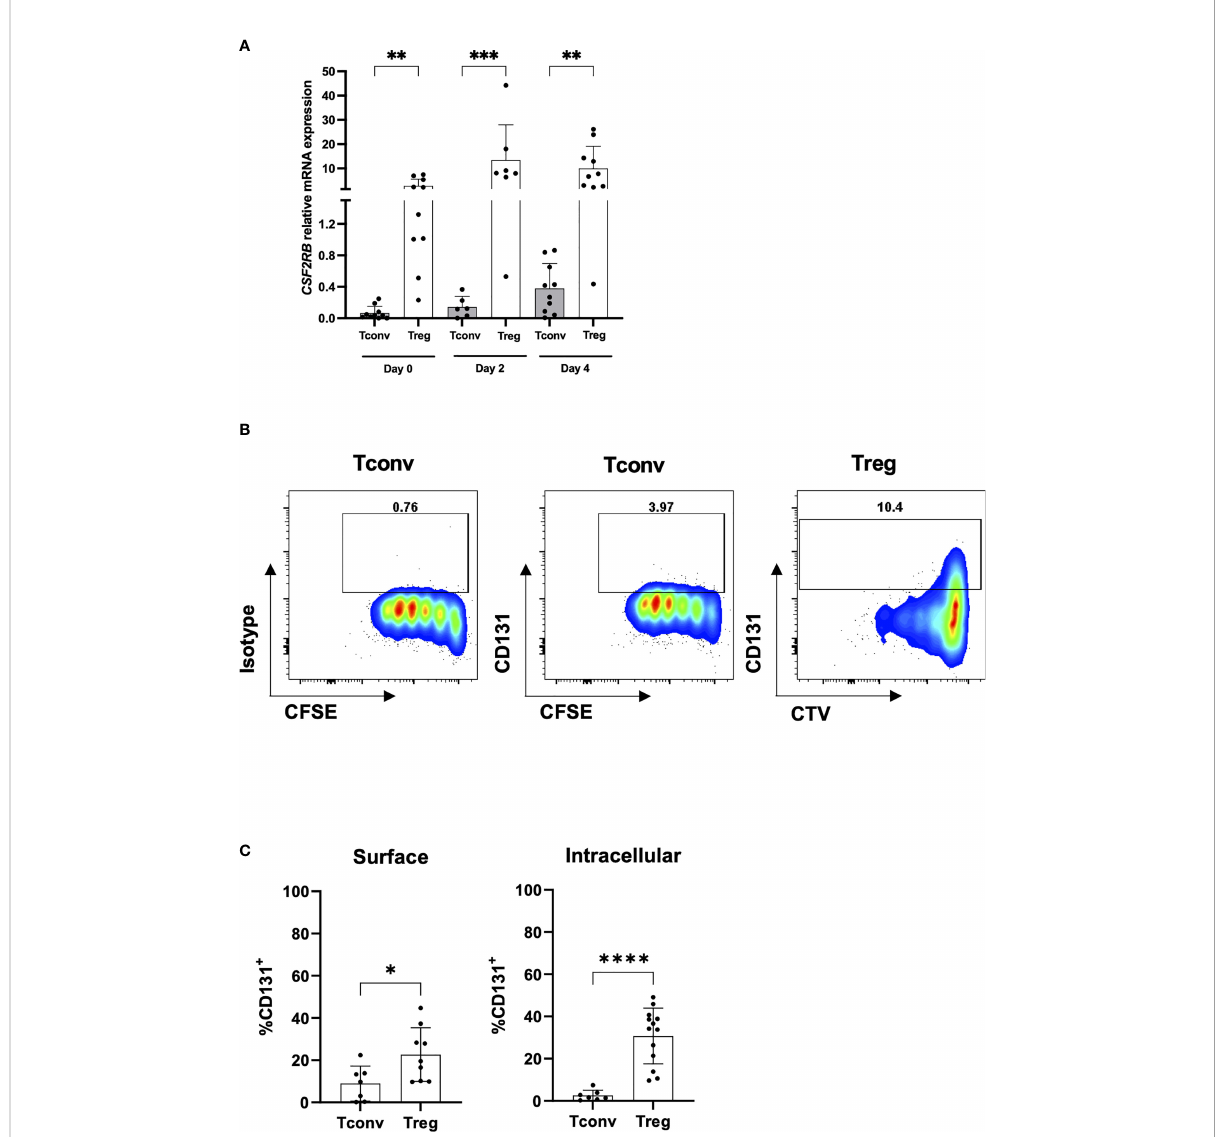
FIGURE 2 CD131 expression on TCR-stimulated CD4 + CD25 - Tconvs and Tregs. (A) Relative CSF2RB mRNA levels in fl ow-sorted CD4 + CD25 - CD127 + Tconv and CD4 + CD25 + CD127 - Treg cells from human PBMCs upon in vitro stimulation with anti-CD3/CD28 mAbs and IL-2. Cells were stimulated with 1 or 10µg/ml anti-CD3 mAb, 1µg/ml anti-CD28 mAb and 25 or 300U/ml IL-2 (n= 6-10). The relative quantities of CSF2RB mRNA were normalized to the expression of B2M mRNA. Graph includes data from Figure 1A at day 0 for comparison (B) CD131 intracellular protein expression was studied in CD4 + CD25 - CD127 + Tconvs and CD4 + CD25 + CD127 - Tregs fl ow-sorted from human PBMCs, labelled with cell proliferation trackers CFSE or CTV and in vitro -stimulated with anti-CD3/CD28/CD2 coated beads for 4 days in the presence of 25U/ml IL-2. One representative donor out of two is shown. (C) CD131 surface and intracellular protein expression was studied in CD4 + CD25 - CD127 + Tconv and CD4 + CD25 + CD127 - Treg cells stimulated for 4 days using 1µg/ml anti-CD3 mAb, 1 µg/ml anti-CD28 mAb and 25U/ml IL-2 (n= 7-13 independent donors). Graphs display mean ± SD. Normal distribution was calculated by Shapiro-Wilk normality test with a signi fi cance level of 0.05. Signi fi cance was calculated by (A) Kruskal-Wallis test with Dunn ’ s multiple comparisons test and (C) unpaired two-tailed t test for normal distributed data. * for P ≤ 0.05 ** for P ≤ 0.01,*** for P ≤ 0.001, **** for P ≤